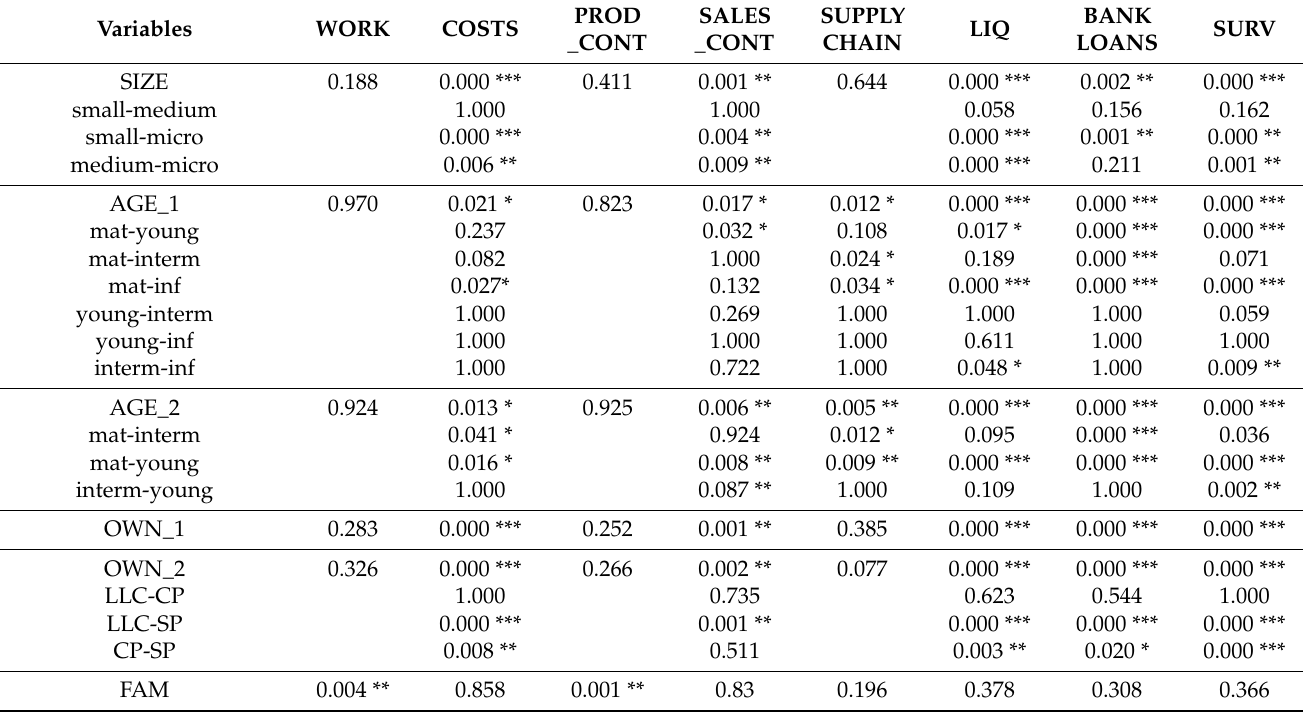
Table A3. Pair-wise comparisons for Kruskal–Wallis test.